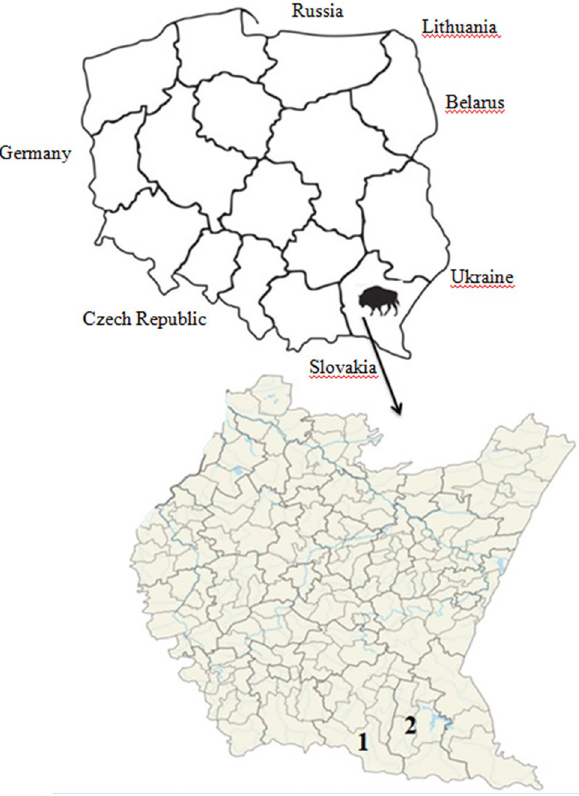
Figure 2. Study area showing the locations of the Forest Districts: Komańcza (1) and Baligród (2) (Microsoft Paint 11.2208.6.0; www. micro soft.